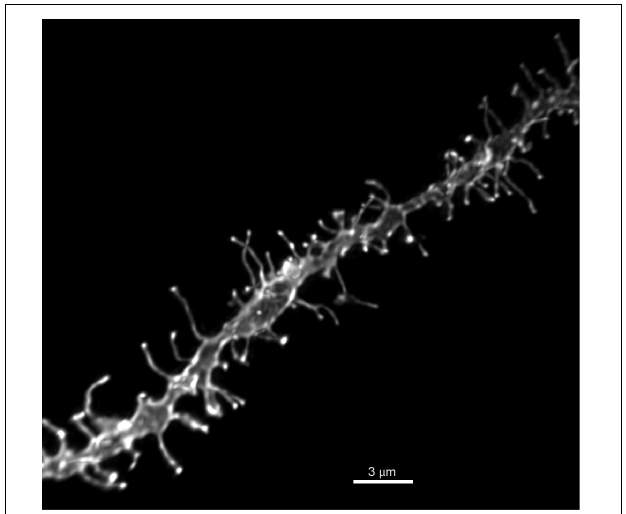
FIGURE 1 | Representative image of DiI dendritic segment. High power (60 × ) reconstruction of a DiI labeled NAcSh MSN dendritic segment, scale bar 3 µ